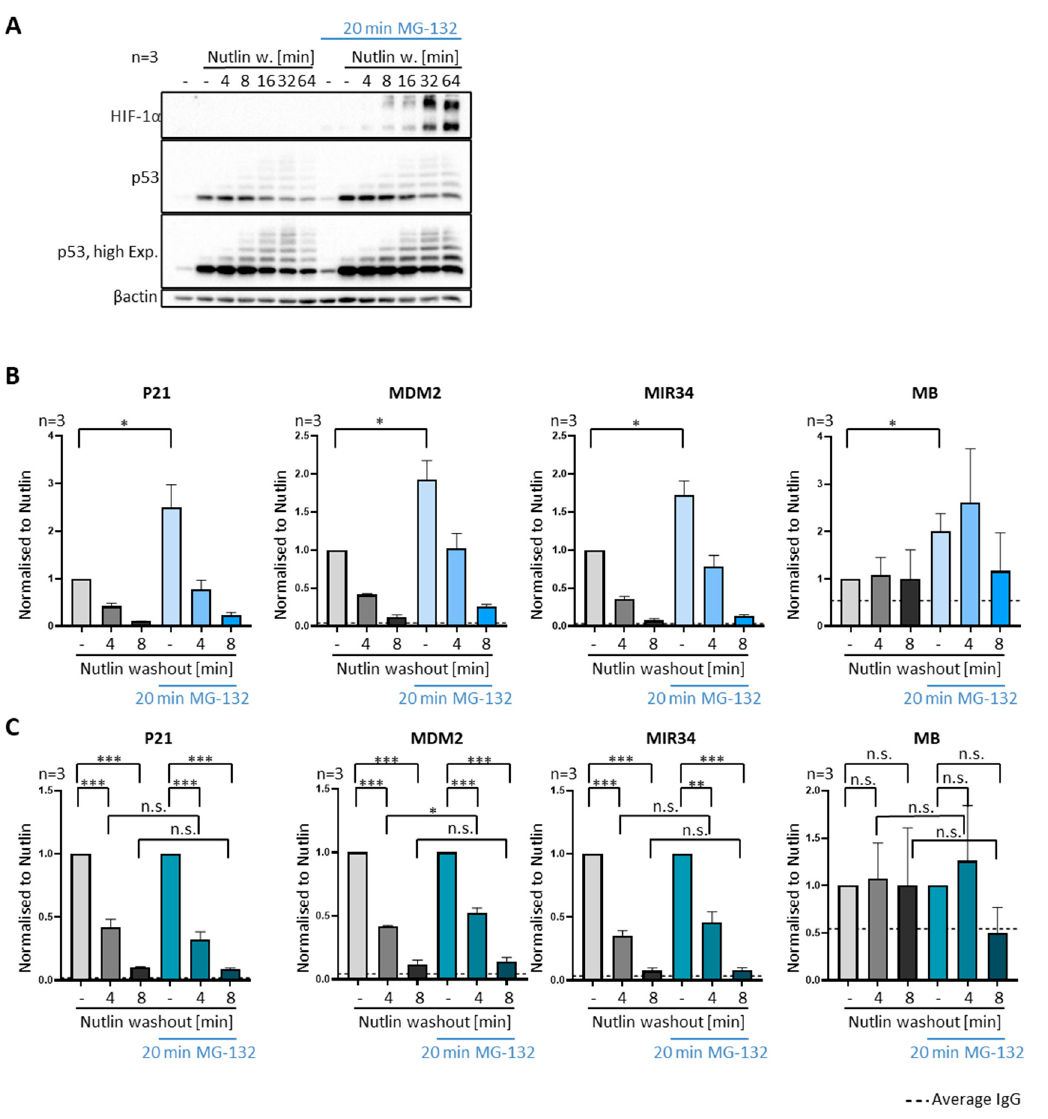
Figure 4. Removal of p53 from promoters independent of proteasome activity. ( A – C ) To inhibit the proteasome for a brief period, SJSA cells were treated with the pharmacological proteasome inhibitor 20 μ M MG-132, or DMSO alone, for 20 min prior to Nutlin washout. Proteasome inhibition was continued after Nutlin was removed. ( A ) The delayed degradation of p53 as well as the accumulation of ubiquitinated p53 upon proteasome inhibition is visible in representative immunoblots. HIF-1 α , a protein with particularly high turnover [22], was detected to control proteasome inhibition. ( B ) A brief pulse of MG-132 increases the amount of DNA-bound p53 but does not compromise p53-removal from promoters upon Nutlin washout, as revealed by ChIP analysis. Three biological replicates, mean + SEM. ( C ) The same data as in ( B ) but normalized as described for Figure 3E, visualizing comparable removal of p53 from its cognate promoters regardless of short proteasome